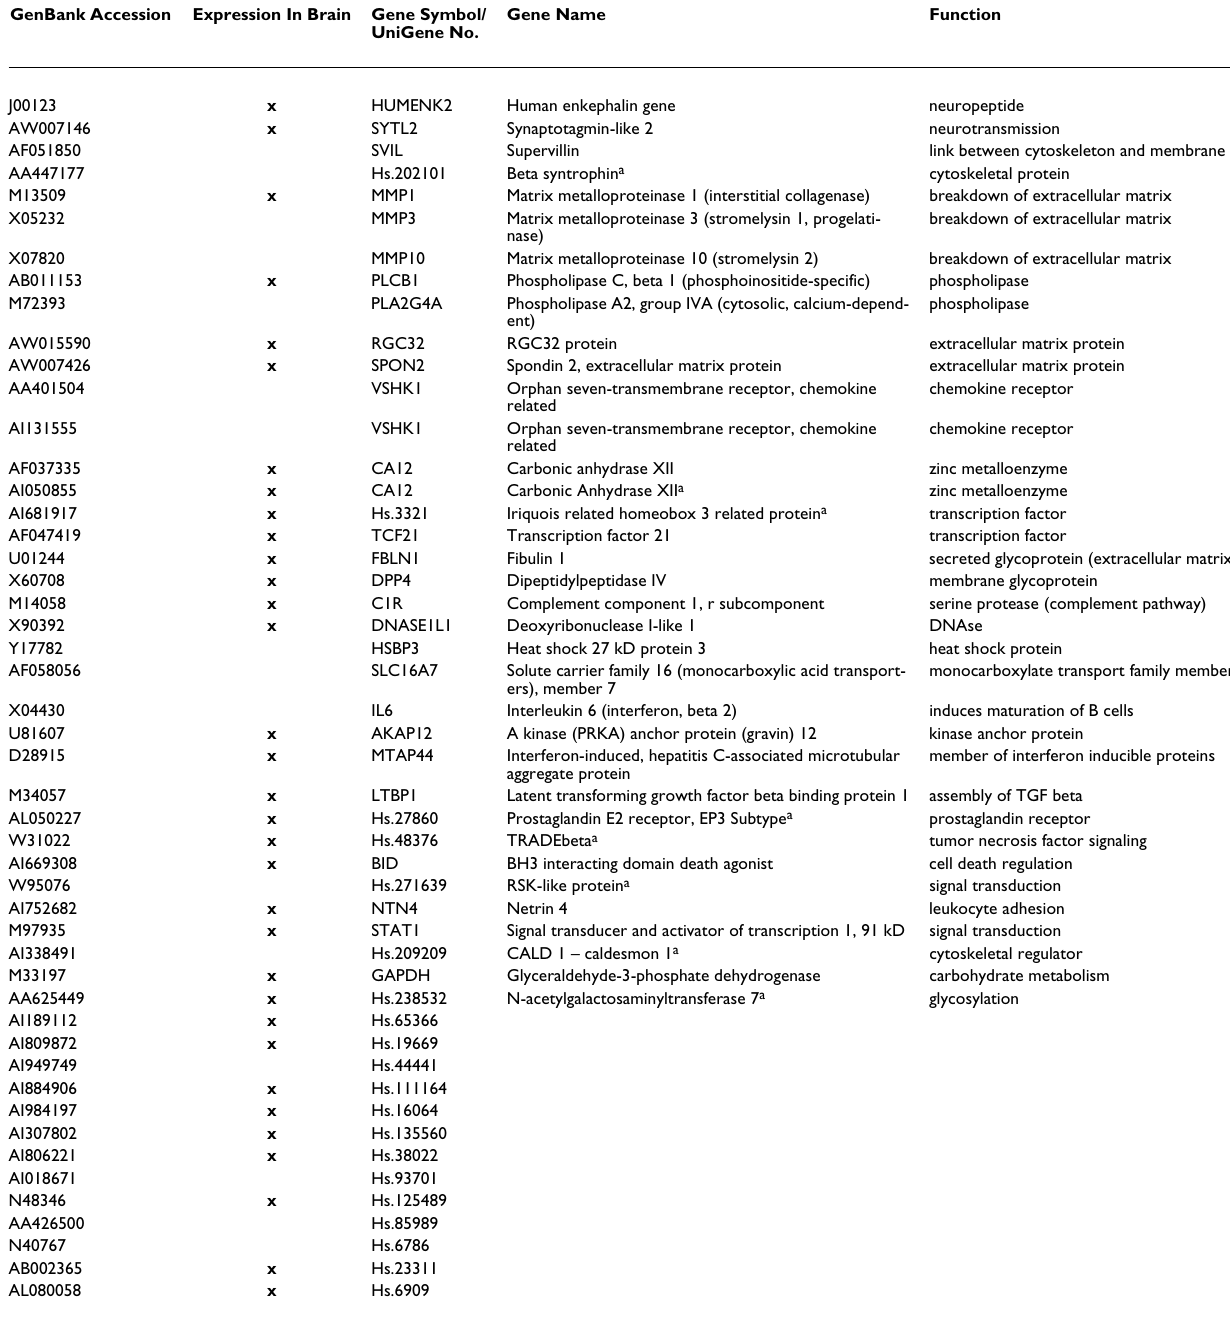
Table 1: Genes with increased levels of expression in at least 3 of 4 mutant MeCP2 expressing clonal fibroblast cell strains when com- pared to matched clonal wild type MeCP2 expressing cell strains GenBank Accession Expression In Brain Gene Symbol/ UniGene